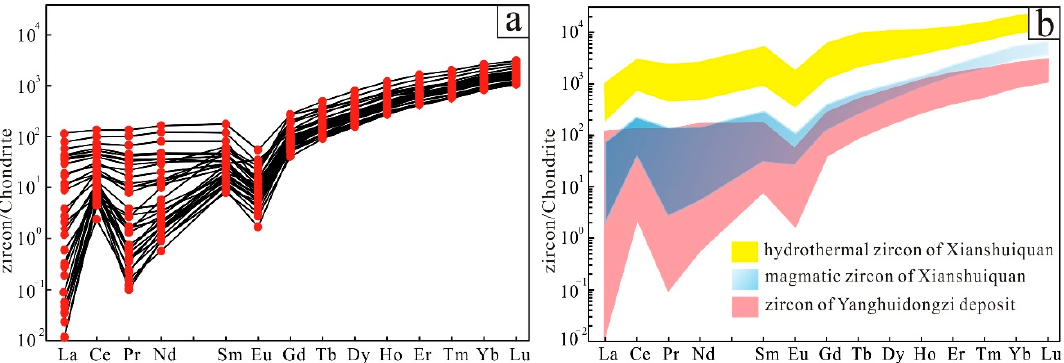
Figure 5. ( a ) Yanghuidongzi zircons chondrite-normalized REE patterns, ( b ) a comparison of zircon chondrite-normalized REE patterns in Yanghuidongzi and Xianshuiquan (the Xianshuiquan values are from Tang et al. [38]; normalization values are from McDonough and Sun (1995) [39]).